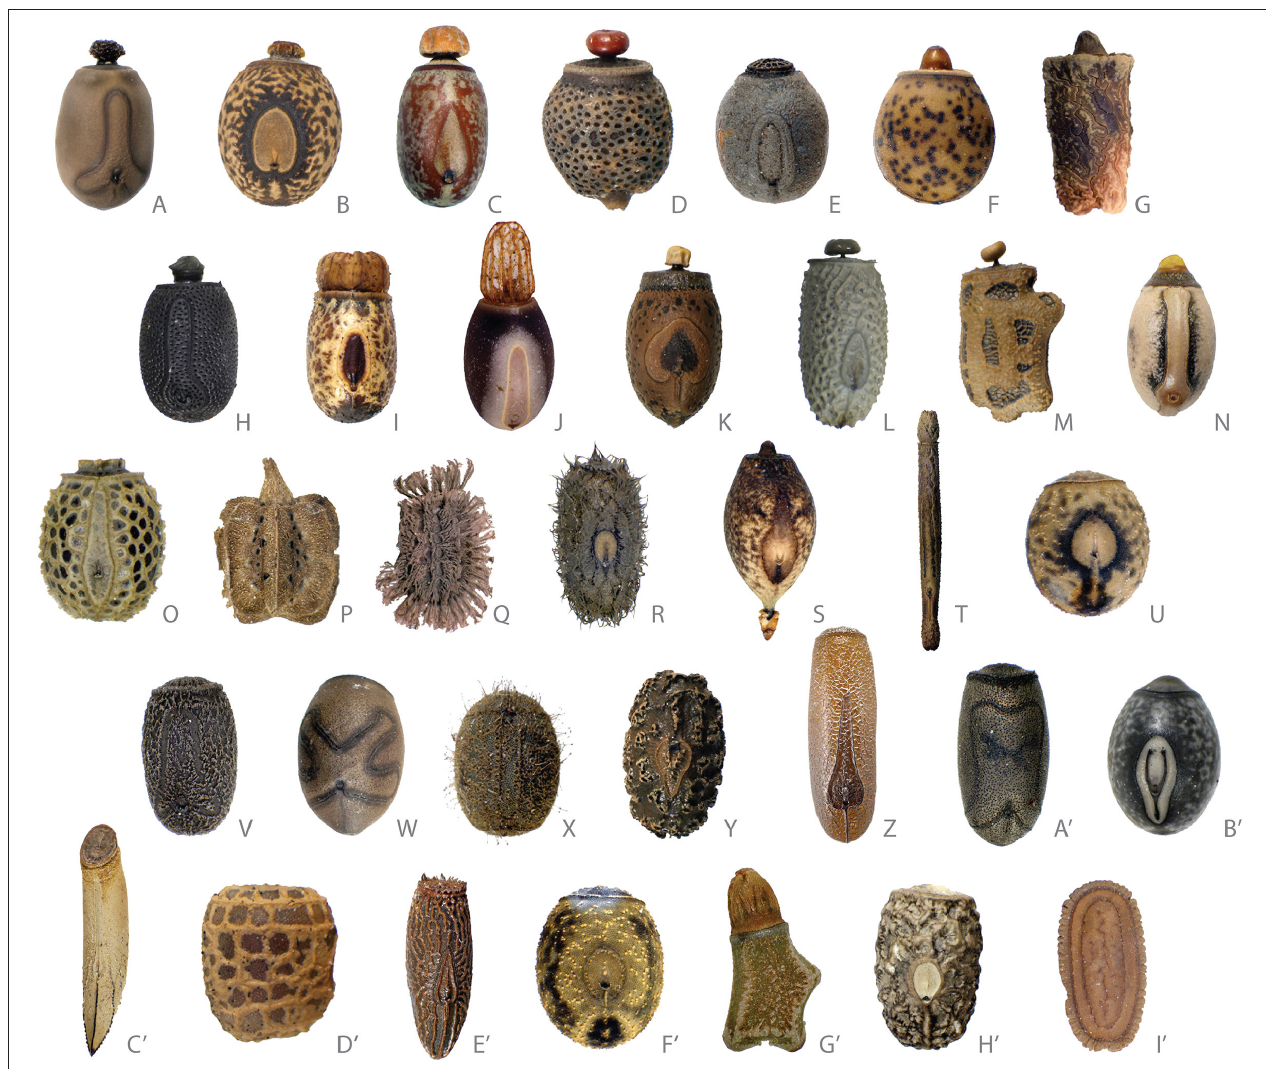
FIGURE 3 | Stick and leaf insect eggs illustrating the breadth of their phenotypic diversity. Eggs depicted in the top two rows have capitula. Corresponding taxonomic names are provided in Supplementary Table S3 . Photos by François Tetaert, used by